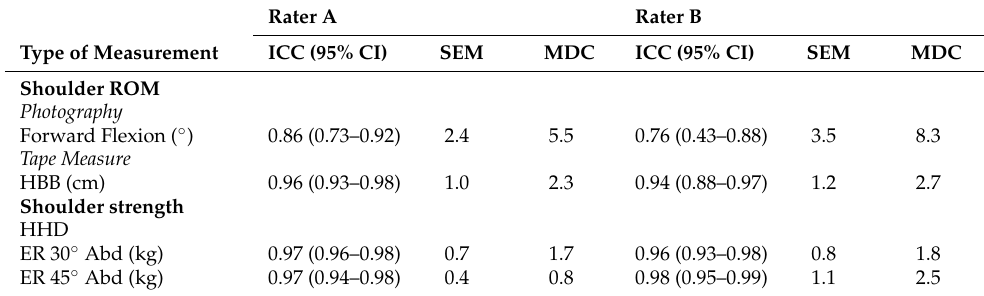
Table 2. Intra-rater reliability for rater A and B (n = 24).